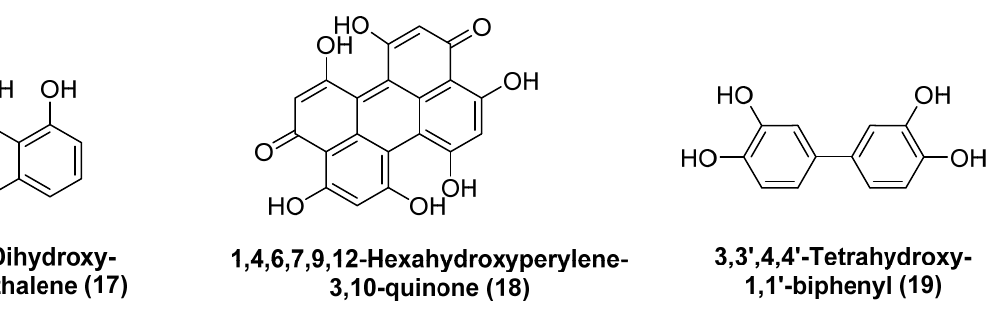
Figure 3. Structures of precursors involved in different types of allomelanin.